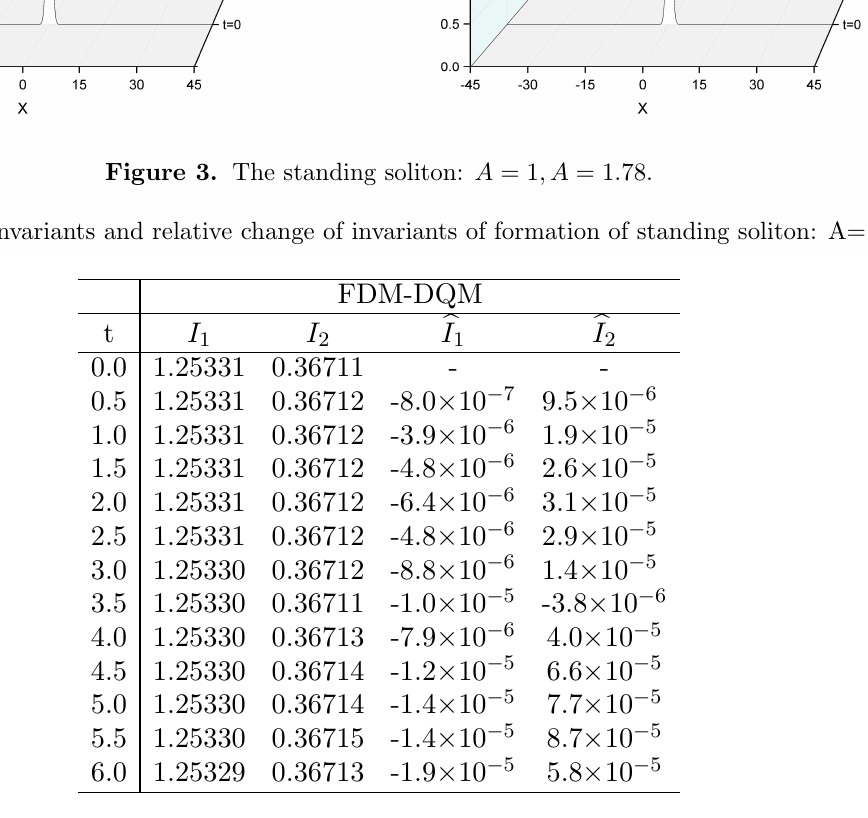
Table 8. Two lowest invariants of the standing soliton: